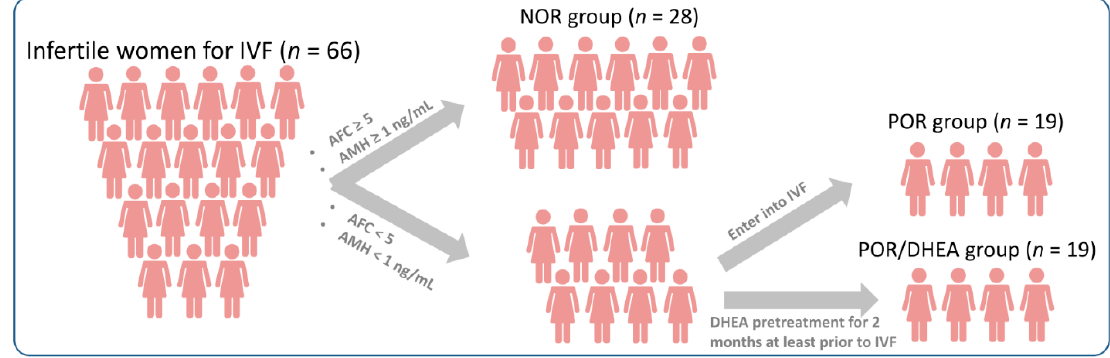
Figure 1. Flow diagram for the selection of eligible studies and subjects.